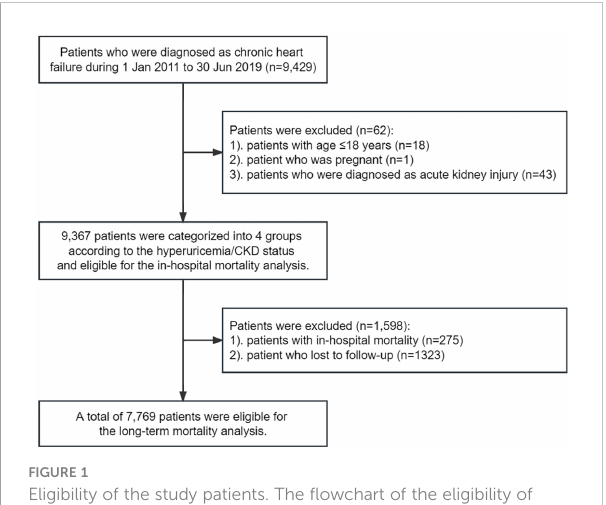
FIGURE 1 Eligibility of the study patients. The fl owchart of the eligibility of 9,367 patients included in the in-hospital mortality analysis, and 7,769 patients included in the long-term mortality analysis.